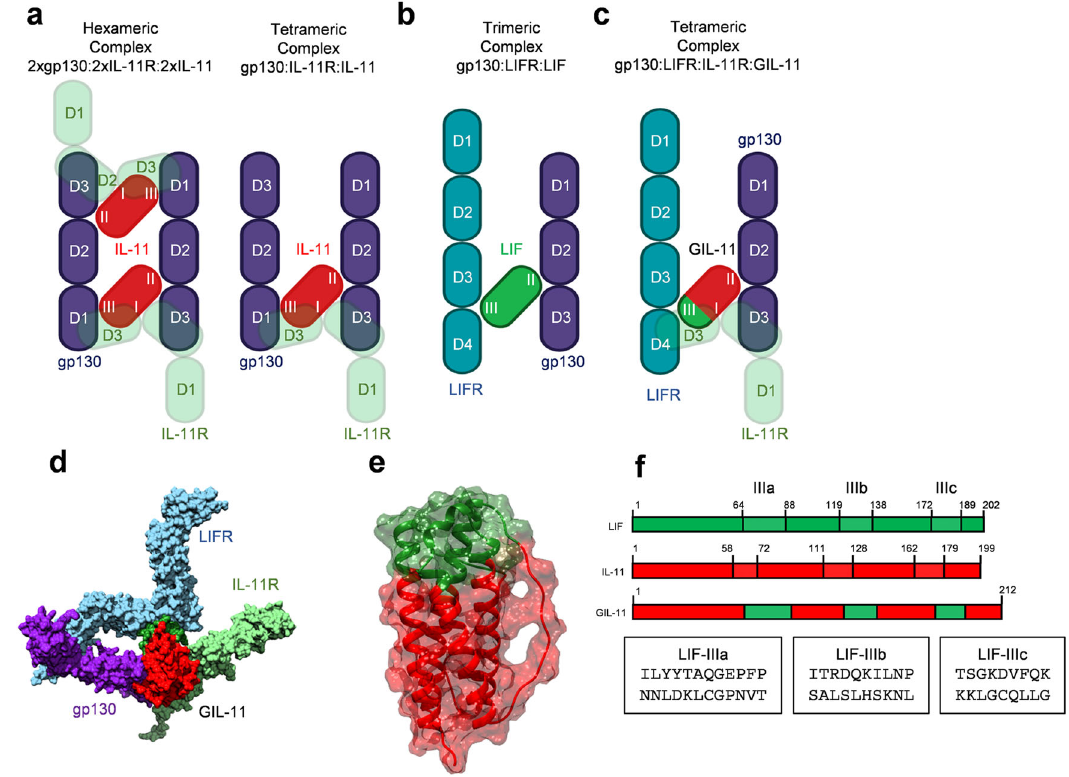
Fig. 1 Design of the cytokimera GIL-11. a schematic illustration of the tetrameric and hexameric IL-11:IL-11R:gp130 receptor complex possibilities. IL-11 initially binds to IL-11R via site I. gp130 is recruited into this complex via major interactions between site III of IL-11 and D1 (Ig-like) of gp130 and site II of IL- 11 and D2/D3 (cytokine binding module (CBM)) of gp130. b schematic illustration of the trimeric LIF:gp130:LIFR complex. LIF binds via site III to D3/D4 of LIFR and via site II to D2/D3 of gp130. c schematic illustration of the tetrameric GIL-11:IL-11R:gp130:LIFR complex. GIL-11 binds via site III to D3/D4 of LIFR, via site II to D2/D3 of gp130 and via site I to D2/D3 of IL-11R. d schematic illustration (left) and space fi ll model (right) of the tetrameric GIL-11:IL- 11R:LIFR:gp130 (PDB 6O4P; 11 2Q7N; 83 1P9M 10 ). GIL-11 binds via site I to IL-11R, via site II to gp130 and via site III to LIFR. e Combined transparent space fi ll/ band model of GIL-11, red: IL-11, green: exchanged region by LIF. f Structure-based schematic sequence alignment of hIL-11 (PDB 6O4O 11 ), hLIF (PDB 1PVH 33 ) and the resulting GIL-11. Site IIIa,b,c residues are highlighted in green and red